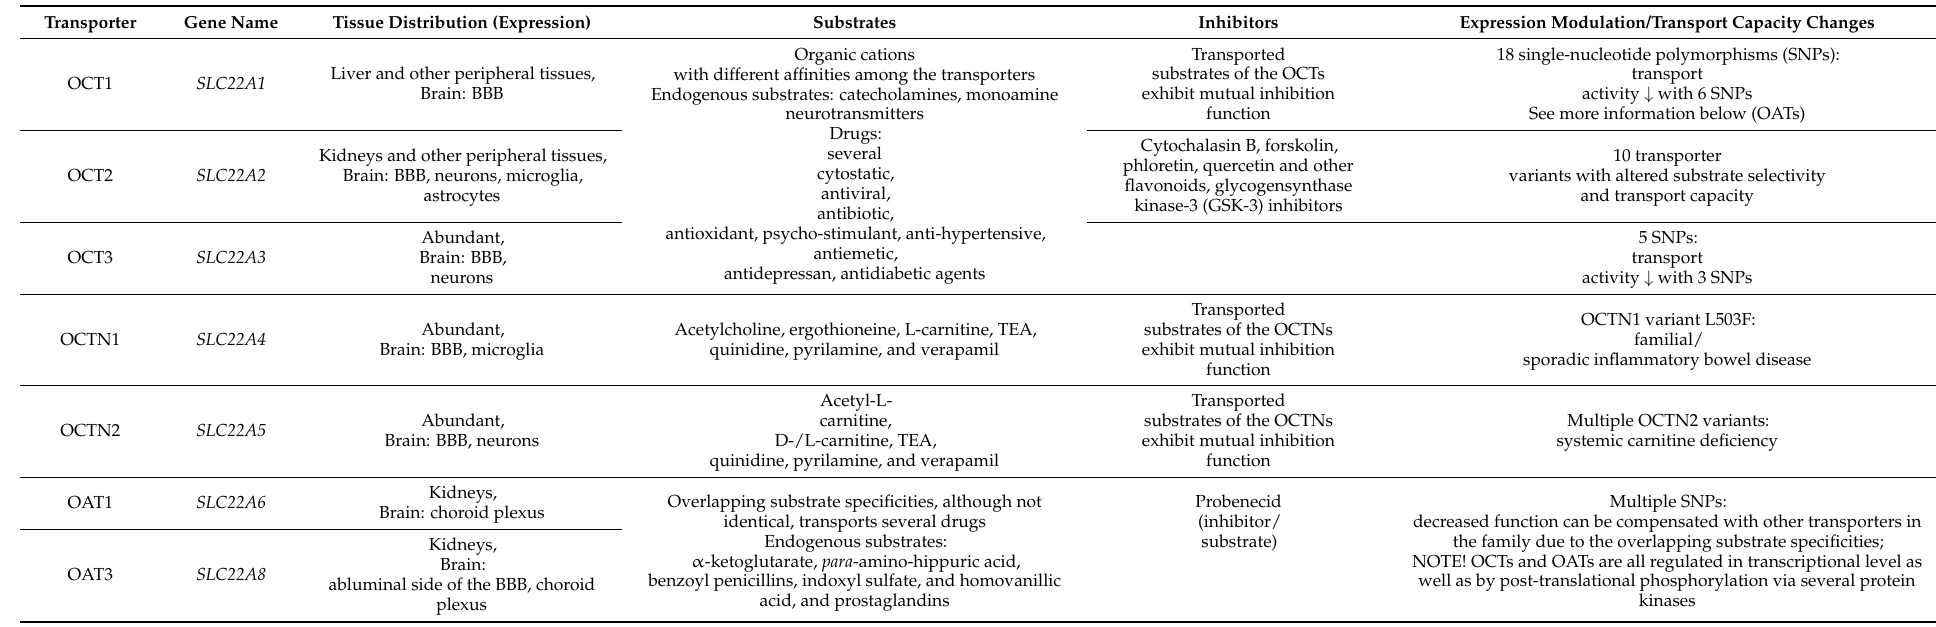
Table 6. Tissue distribution, substrates, inhibitors, and expression/function modulators of OCT1–3, OCTN1–2, and